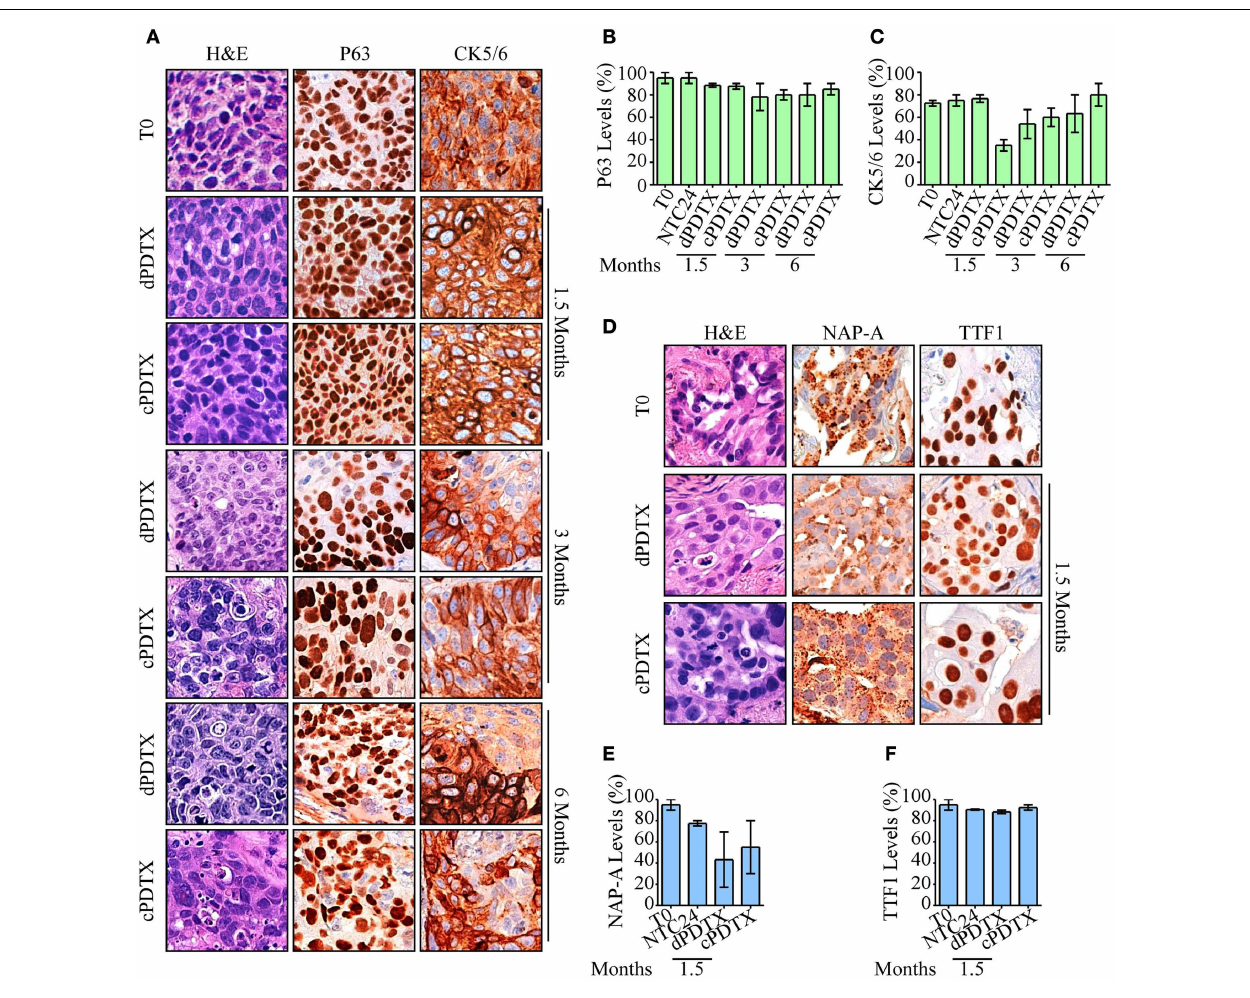
magnification 200 × . (D–F) Immunoreactivity of AC-PDTXs and corresponding human tissues for NAP-A andTTF1 markers was analyzed, and a representative AC case is shown. (D) Quantification of NAP-A (E) and TTF1 (F) proteins levels in T 0 , NTC24 samples, and relative xenografts at 1.5months after the graft. Original magnification 200 × . For all experiments, bars represent mean ±